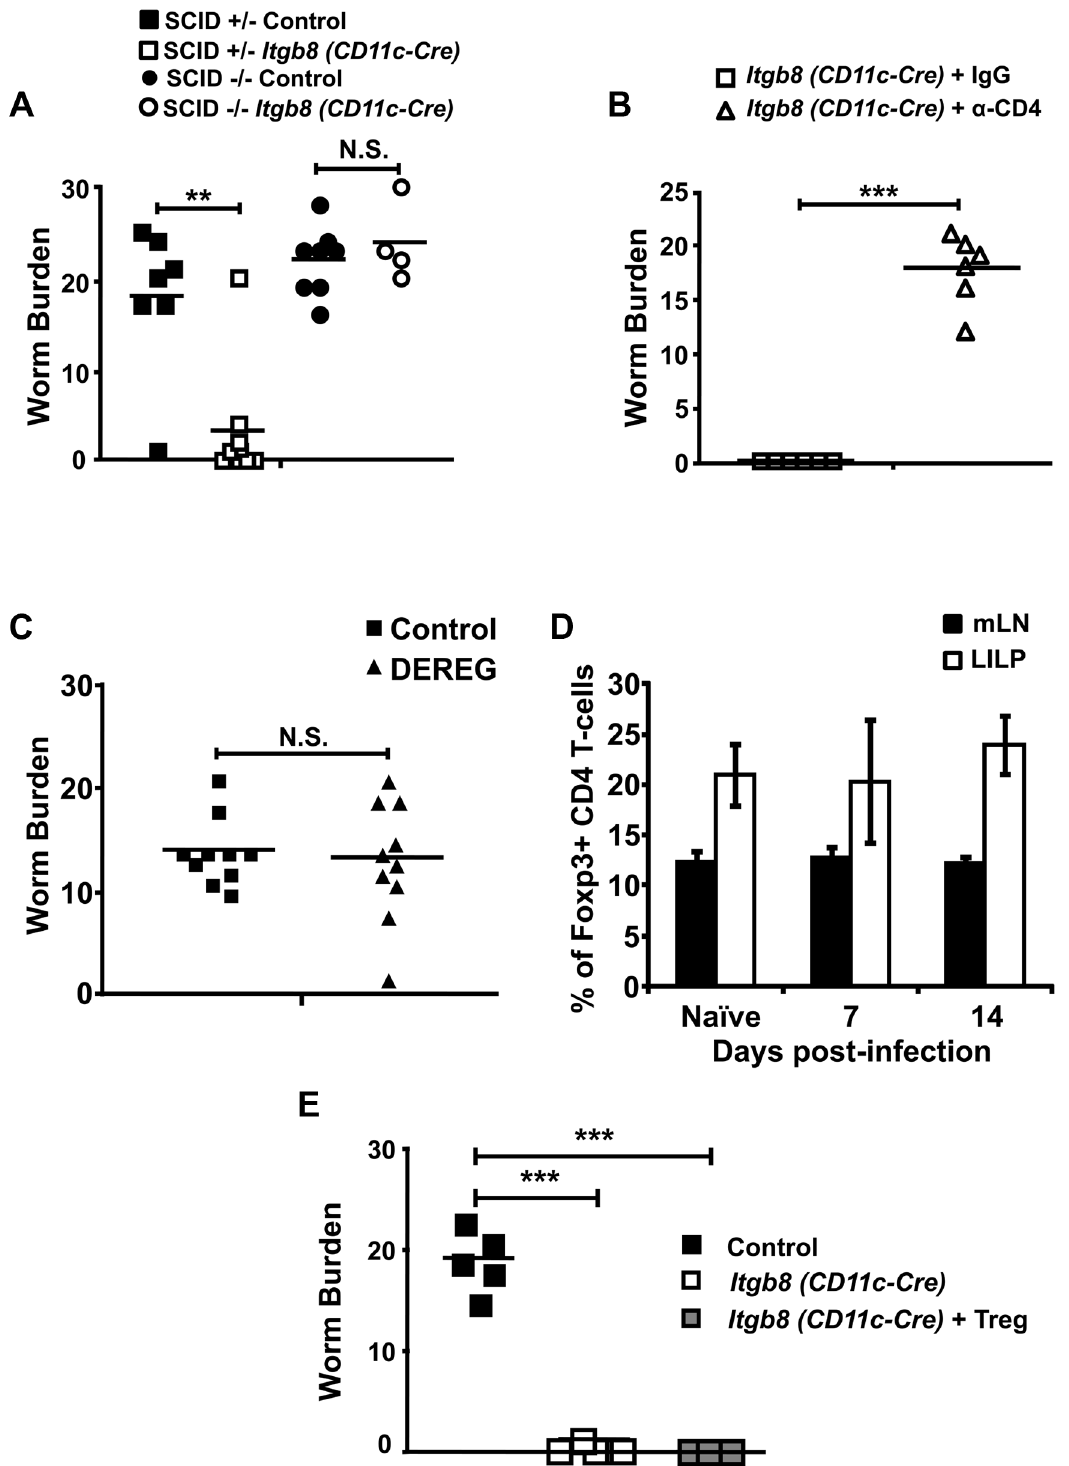
Figure 3. Protection from chronic T.muris infection in mice lacking the TGF b -activating integrin a v b 8 on DCs is dependent on CD4 + T-cells, but does not involve Foxp3 + Tregs. ( A ) Worm burdens from control and Itgb8 (CD11c-Cre) mice crossed onto a SCID background analysed at day 32 post-infection (p.i.) with a chronic dose of T.muris eggs. Data (n=4–9 mice per group) are from two independent experiments performed. ( B ) Worm burdens from Itgb8 (CD11c-Cre) mice infected with a chronic dose of T.muris eggs and treated with 2 mg of control IgG or anti- CD4 antibody (YTS191) analysed at day 17 p.i. Data (n=6 mice per group) are from two independent experiments performed. ( C ) Control and DEREG mice were infected with a chronic dose of T. muris eggs, injected i.p. with 200 ng diphtheria toxin every 2 days (starting 2 days before infection) and worm burdens analysed at day 14 p.i. Data (n=10 mice per group) are from two independent experiments performed. ( D ) Percentage of Foxp3 + Tregs of CD4 T-cells in mLN, IEL and LILP populations during T. muris infection as analysed by flow cytometry. Data (n=7–11 mice per group) are from